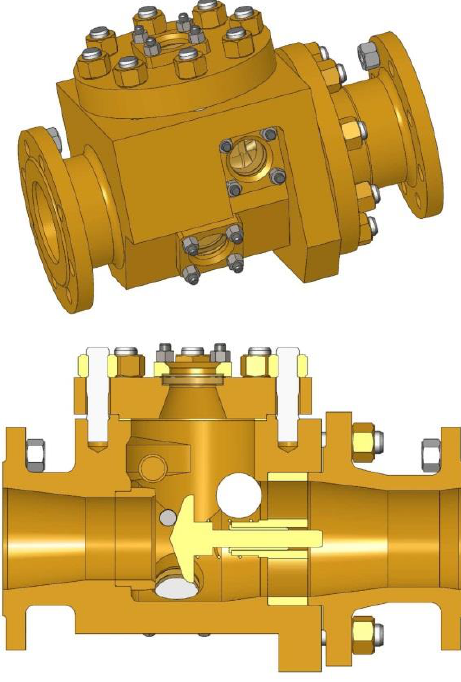
Axial check valve - BZV is based on the axial check valve. In case of BZV the flow parts were hydraulically optimized to reduce energy loss but keep the same dynamic properties as in the axial check valve. It results the BZV has a lower pressure loss than the axial check